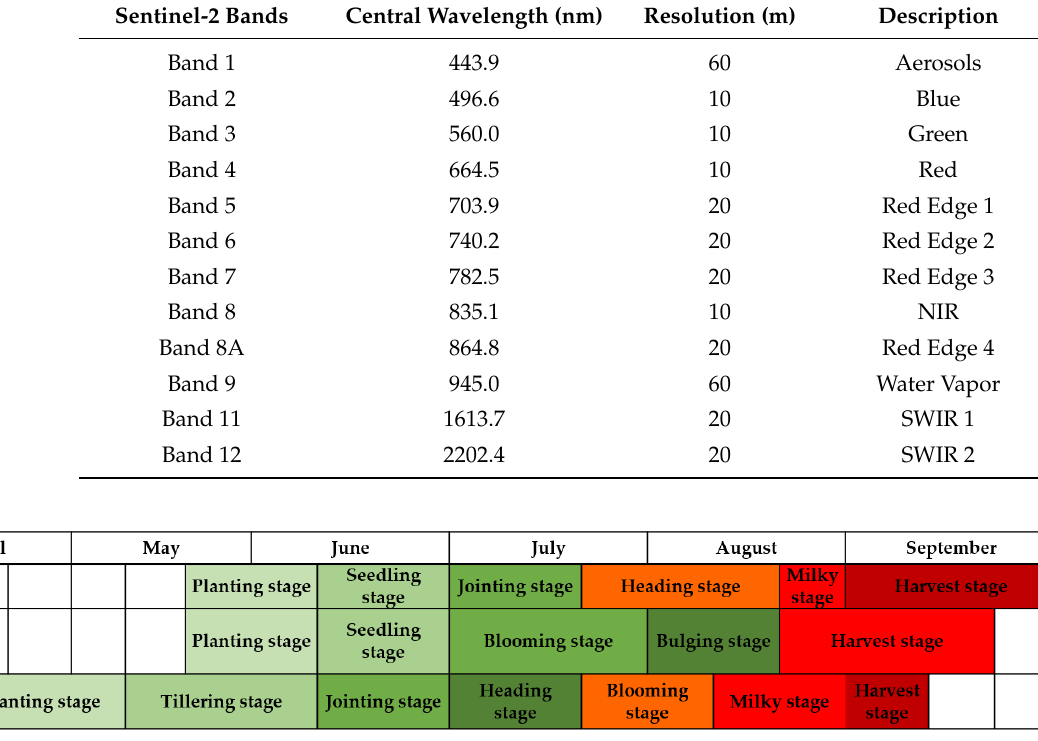
Figure 3. Phenology of corn, peanut, and